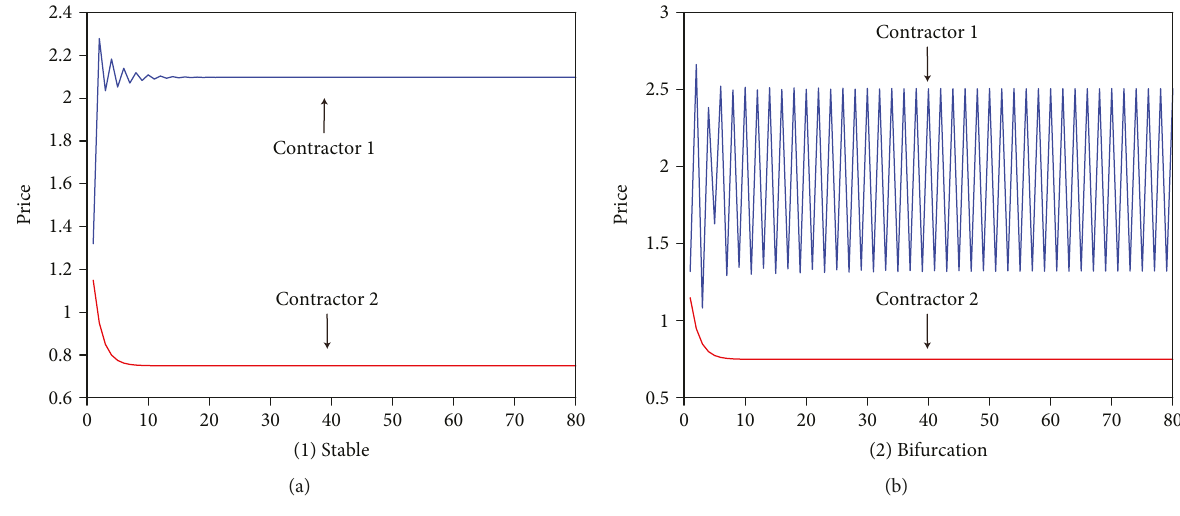
Figure 5: Sequence diagram for stability and bifurcation in situation 2.